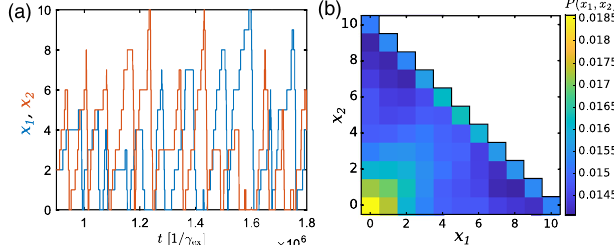
FIG. 12. Results of the transfer matrix analysis of W . (a) Prob- FIG. 13. In-phase synchronization in an asymmetric three-state ability disturbance δ P at the edge (in logarithmic scale) as a tot model. (a) Trajectories for two coupled three-state models, both function of the chirality parameter c and the ratio parameter r . with identical, asymmetric internal transition rates γ given by (b) Edge flux J as a function of the same parameters. Both the in edge γ CB ¼ 10 − 4 γ ex for the horizontal transitions, γ AC ¼ 10 − 3 γ ex for probability disturbance and the flux vanish in the achiral, in in the diagonal transitions, and γ BA ¼ 10 − 2 γ ex for the upwards Hermitian case c ¼ 0 . 5 , as well as in the limit r → 0 . The flux in transitions. (b) Probability distribution of finding a given x 1 and also vanishes in the limit r → 1 . Otherwise, the probability x 10 7 > 0 ). The flux is positive always accumulates at the edge ( δ P 2 simultaneously for the same simulation, using a total of tot steps starting from a random initial state. We find that the two (counterclockwise) for c > 0 . 5 and negative (clockwise) for c < 0 . 5 . Note that δ P systems show weak in-phase synchronization, particularly at is given in units of p , and J in tot b edge initial growth. The system size is N x ¼ 10 γ units of p . The black curves represent the boundary r (cid:4) ð c Þ b tot separating the topological and trivial phases of the system.